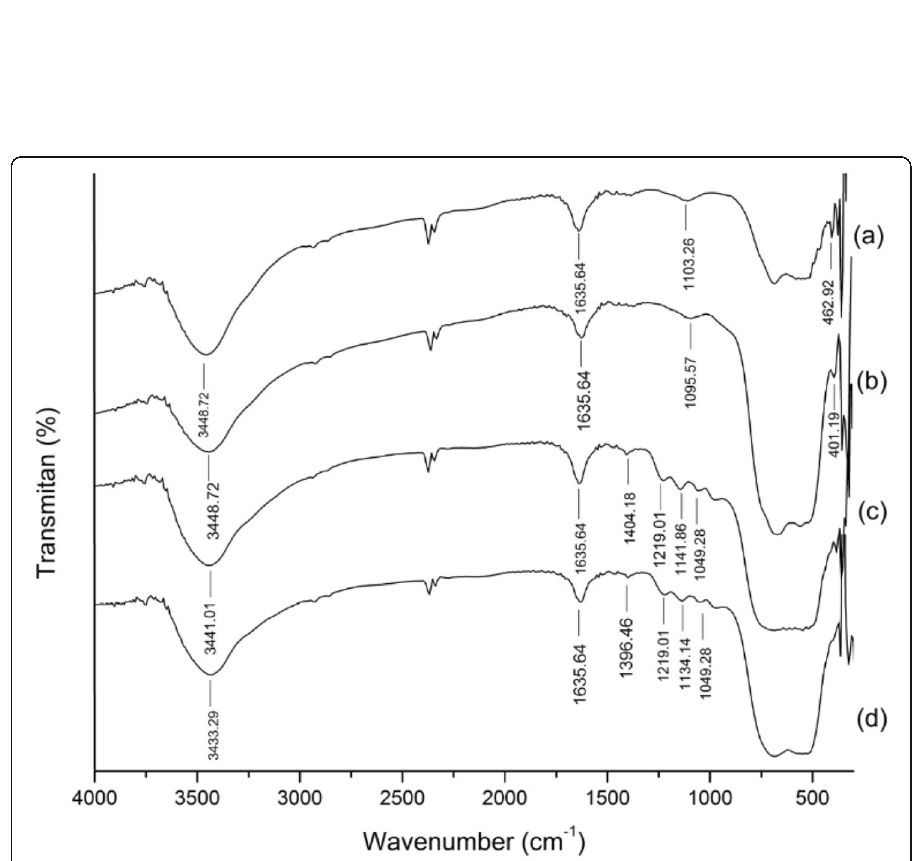
Fig. 3 FTIR spectra of a TiO 2 , b TiO 2 -N,S (1:1:0.5), c TiO 2 -N,S (1:1:1), and d TiO 2 -N,S